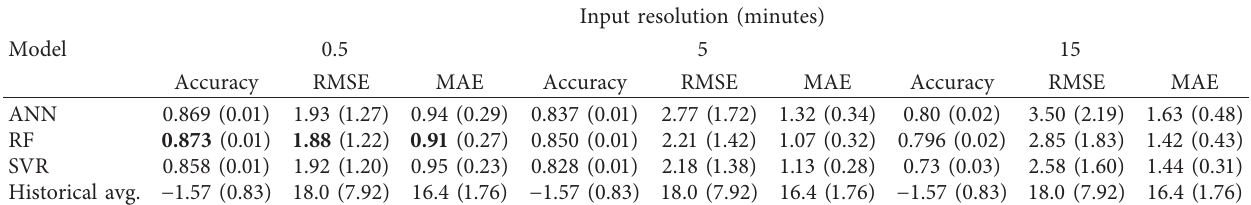
Table 5: Traffic occupancy prediction under nonrecurring congestion